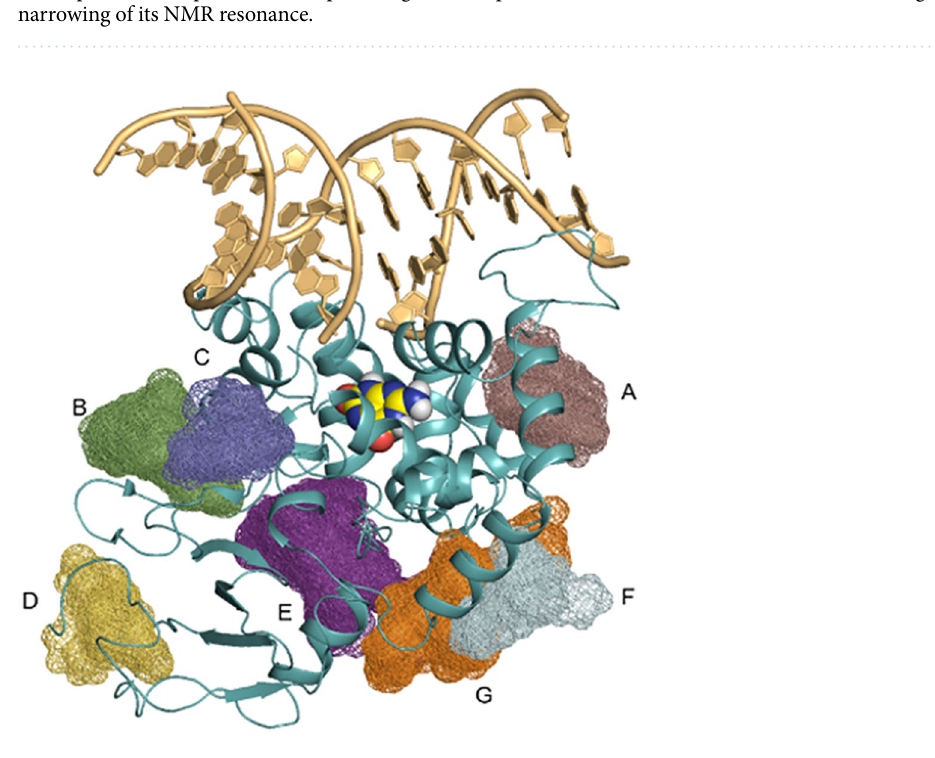
Figure 5. Proposed sites for small molecule OGG1 activator binding. OGG1 (blue ribbon) shown with 8-oxo-dG (yellow spheres) and DNA oligonucleotide (gold) from the cross-liked complex (PDB ID 1HU0). Hot spots ( A – G ) that were identified using mixed probe molecular dynamics were explored via docking experiments. Three hot spots, (B), (E), and (G) could accommodate > 9 small molecule